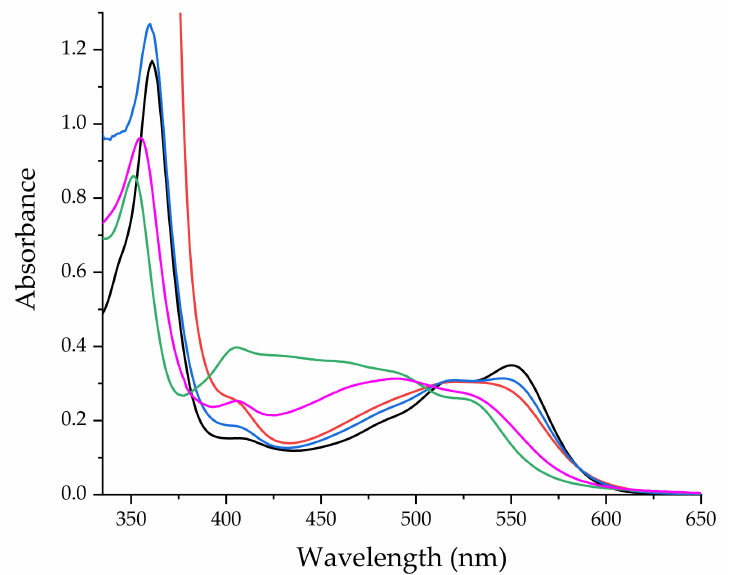
Figure 2. UV-Vis spectra of CblCN (black) and its conjugates with Pd(II) complexes: 1 (pink), 2 (green), 3 (blue) and 4